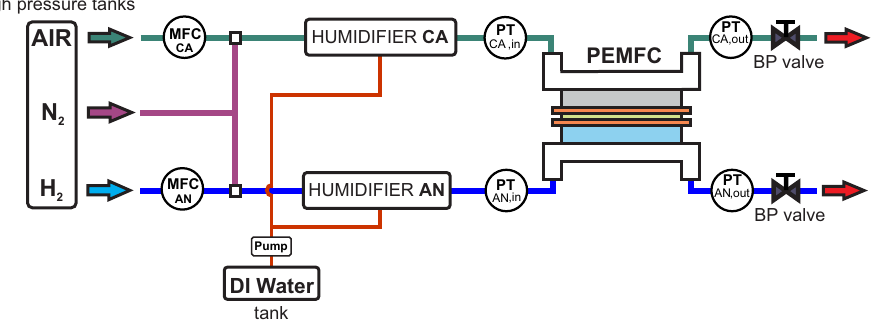
Figure 3. Block diagram of flow loops: Greenlight G60 testing station equipped with a Greenlight Innovation TP50 PEMFC stack. Mass Flow Controllers on the anode and cathode side are noted as MFC ca and MFC an . Pressure Transmiters (sensors) at the cathode and anode inlets and outlets are marked as PT ca , in , PT ca , out , PT an , in and PT an , out . Pressure loop actuator, Back Pressure valve is noted as BP